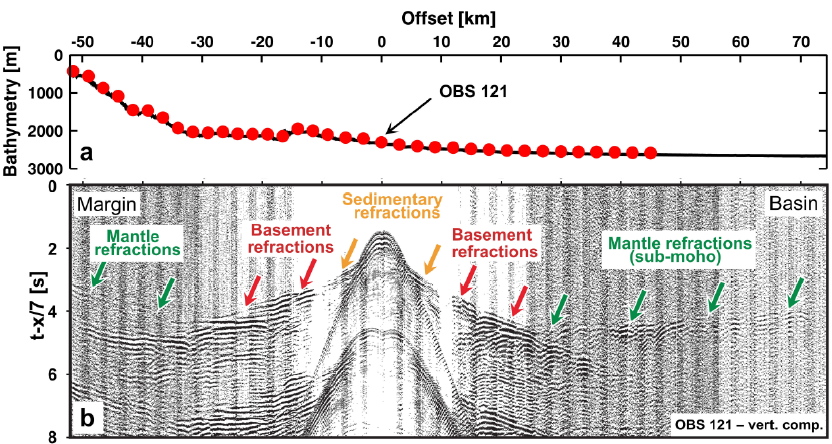
Figure 4. ( a ) Bathymetric variations over the OBS shot profile, with OBS positions denoted by red dots. ( b ) Data from OBS 121 (located in Figure 3) plotted with a 7 km.s −1 reduction velocity. Two intercalated shot passes have been acquired, and resulting data subsequently merged to avoid water-velocity wraparound signals at large offsets. Various refracted phases are observed in first arrival. Mantle refractions are observable from 15–20 km offset onwards (and as first arrivals beyond distances of ~25 km), on each side of the instrument, up to both ends of the shot profile.